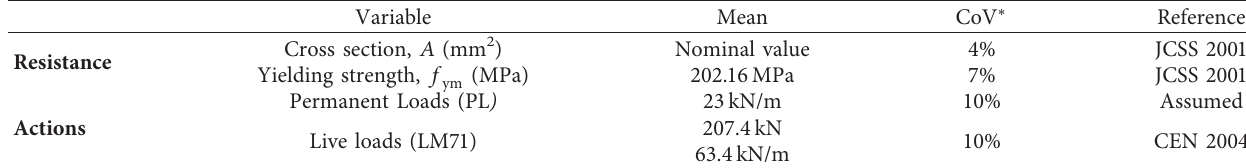
Table 6: Random variables quantification.